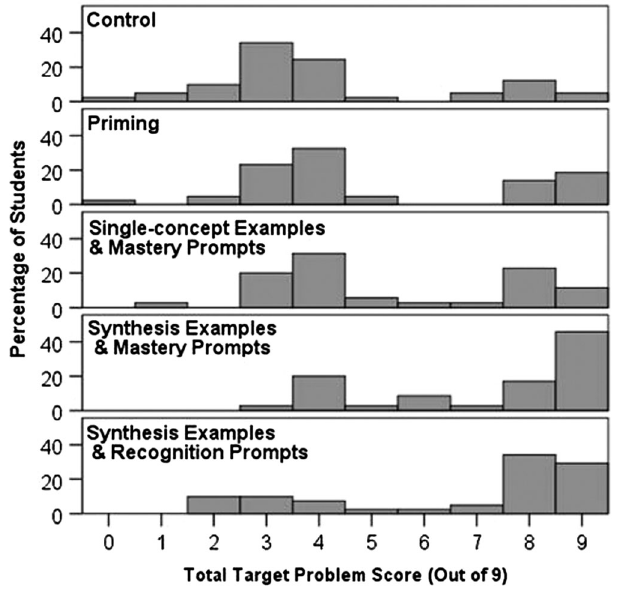
FIG. 3. Distributions of student score on target synthesis problem by treatment condition.